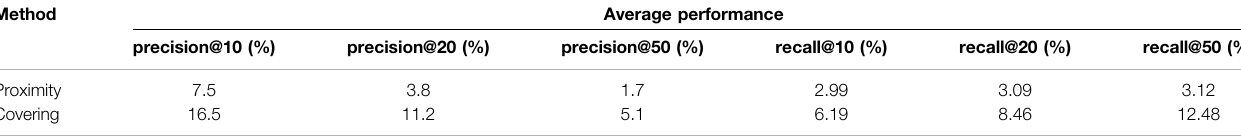
TABLE 1 | Search model performance at predicting cross-references .